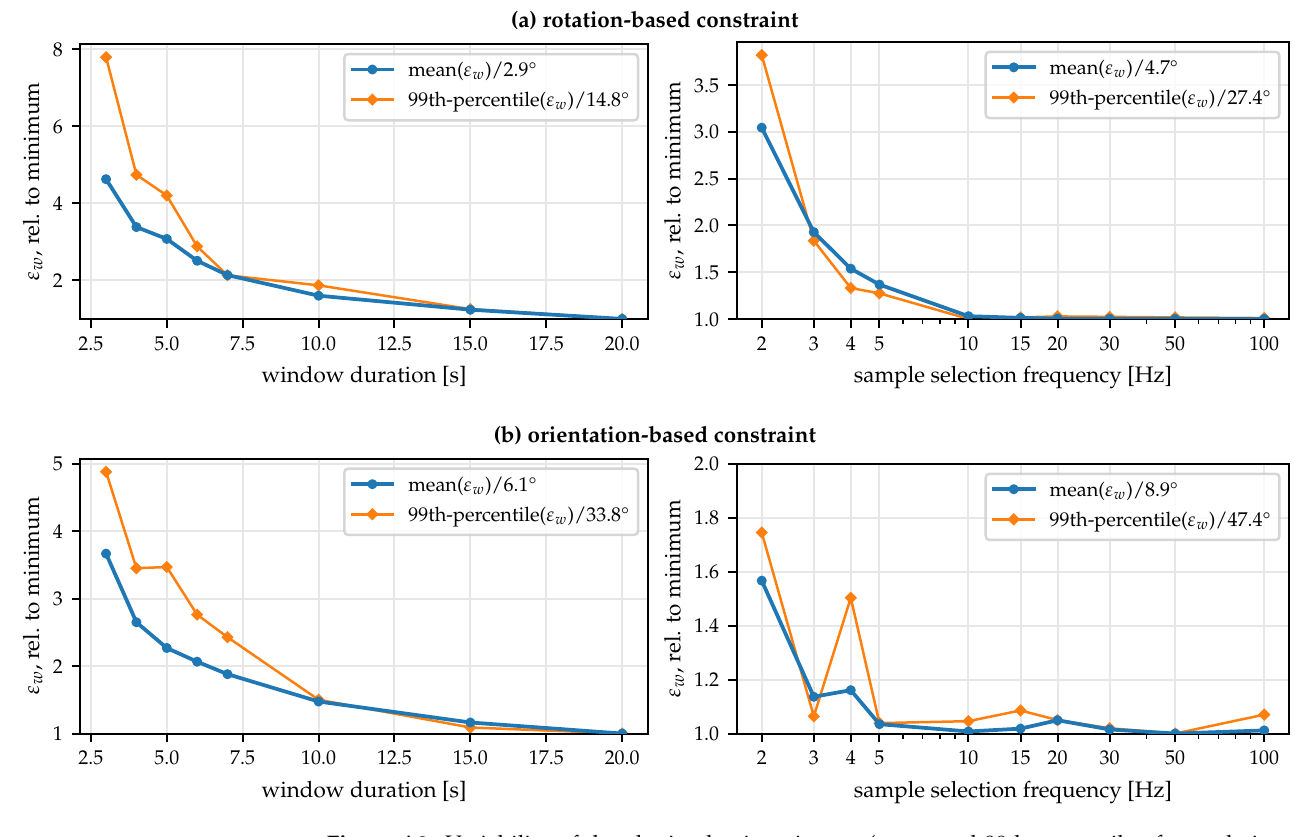
Figure A2. Variability of the obtained axis estimates (mean and 99th-percentile of ε w , relative to minimum value) for different values of the window duration and the sample selection frequency for the ( a ) rotation-based constraint and the ( b ) orientation-based constraint. In general, using more data (long windows at high sampling rates) leads to more consistent estimates but increases inconvenience for the subject and processing